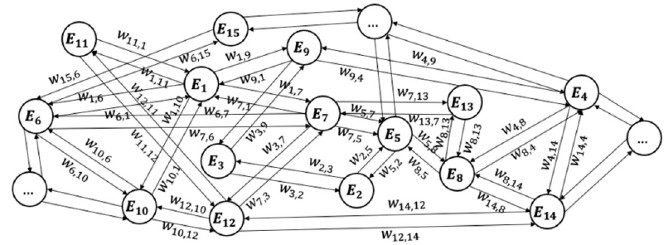
Figure 2. The collaborative relationship between enterprises.